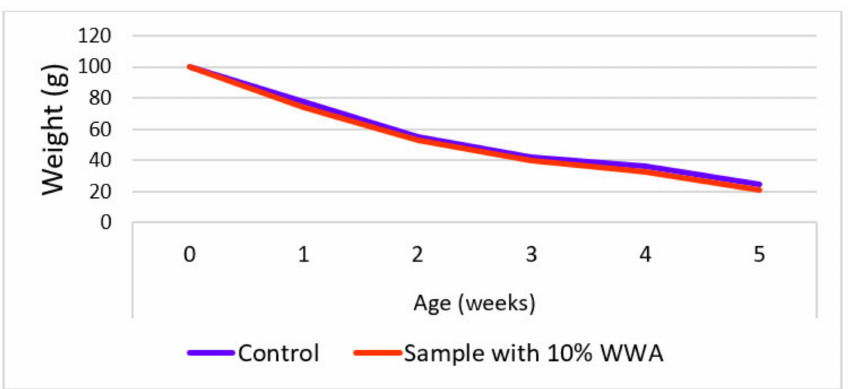
Figure 1. Change in concrete mass with a period of dipping samples in nitric acid (data from reference [82]).